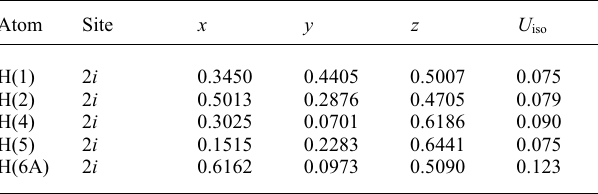
Table 2. Atomic coordinates and displacement parameters (in Å 2 )